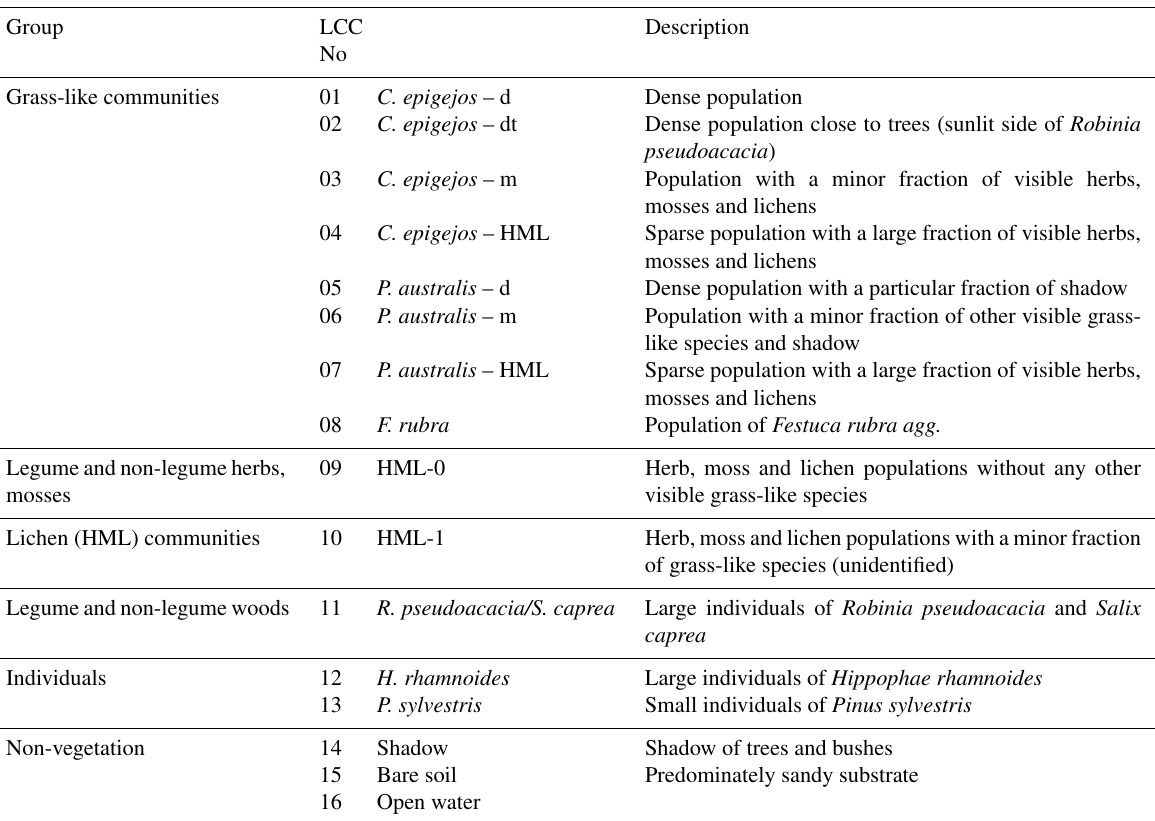
Table 1. List of the 16 relevant land cover classes (LCC) as predefined for classification on the basis of field survey and botanical mappings. Group